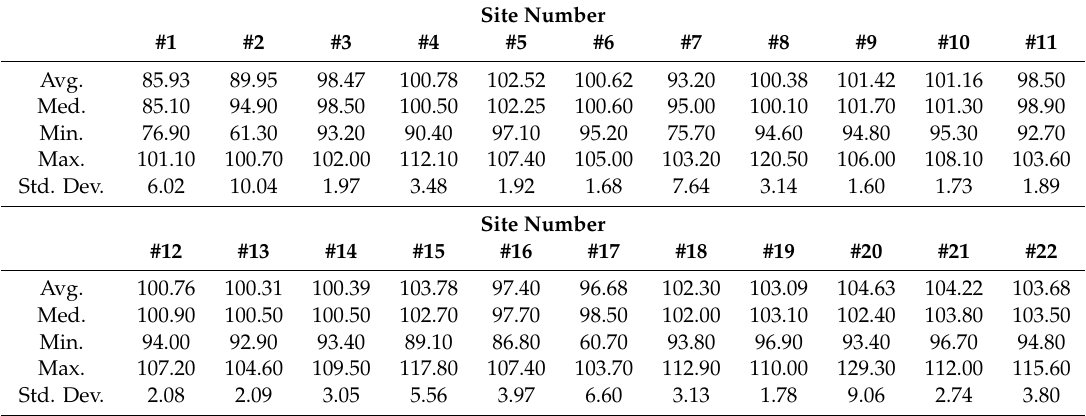
Table A5. Descriptive statistics of dissolved oxygen (%) at each sampling location (n = 22) during study period (2 January 2018–1 January 2019) in West Run Watershed, WV, USA. Avg. = average, Med = median, Min. = minimum, Max. = maximum and Std. Dev. = standard deviation.